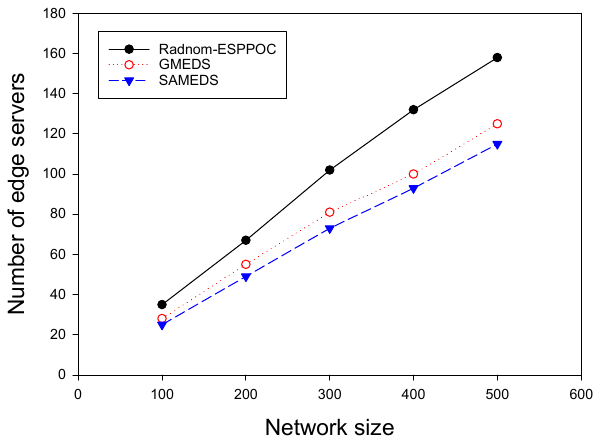
Figure 4. The impact of network size with on-demand